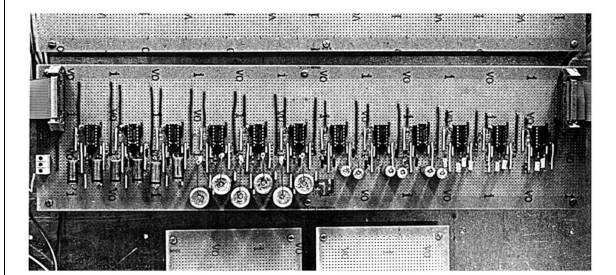
FIGURE 1 | The first filter-bank rhythm analyzer (Todd, 1993a). The original amplitude modulation spectrometer was implemented as an analog system using biquad circuits over the range 0.125–16Hz. Each circuit simultaneously gave a low-pass and band-pass output. It was constructed